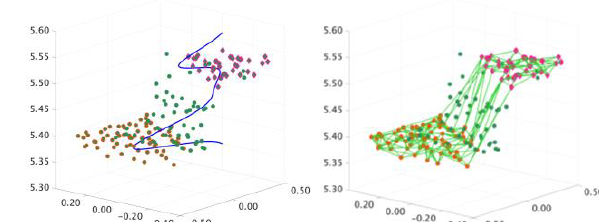
Figure 3. KDE of z-coordinates of the points within C c Next, the points describing the footpath and road surface were extracted based on the KDE. For this task, for each C rc , two peaks on the outmost KDE were first extracted. Then, points within the buffer, [-bw/2, bw/2] of the peak position are extracted and known that the points of the footpath ( P f ) and the road surface ( P r ), respectively (Fig. 4a). Notably, point P f have z-coordinates greater than P r ones. Subsequently, Delaunay triangulation was applied across the mixed P f and P r data set (Fig. 4b). Road edge points ( P cr ) are those within P f that are vertices of triangles connecting both P f and P r (points Fig. 4c).